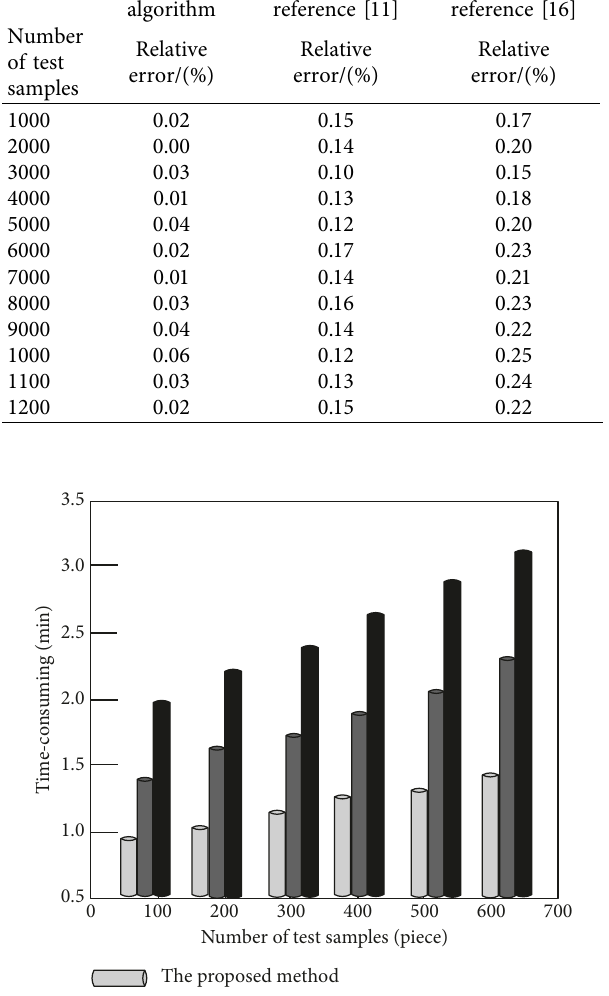
Table 2: Relative error changes of the three algorithms. The proposed